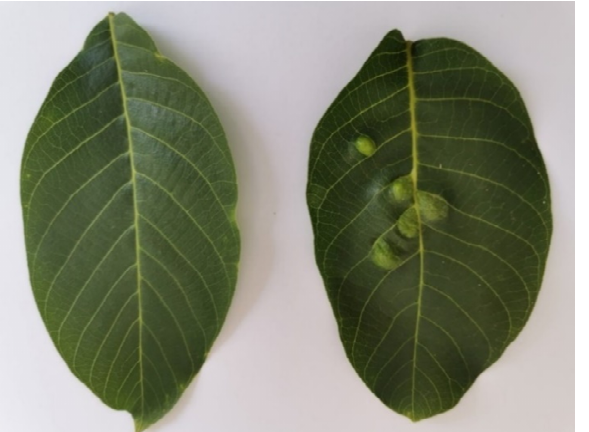
Figure 1. Representative photos of Juglans regia leaflets without (control) and with the erineum- forming mite Aceria erinea infection. forming mite Aceria erinea